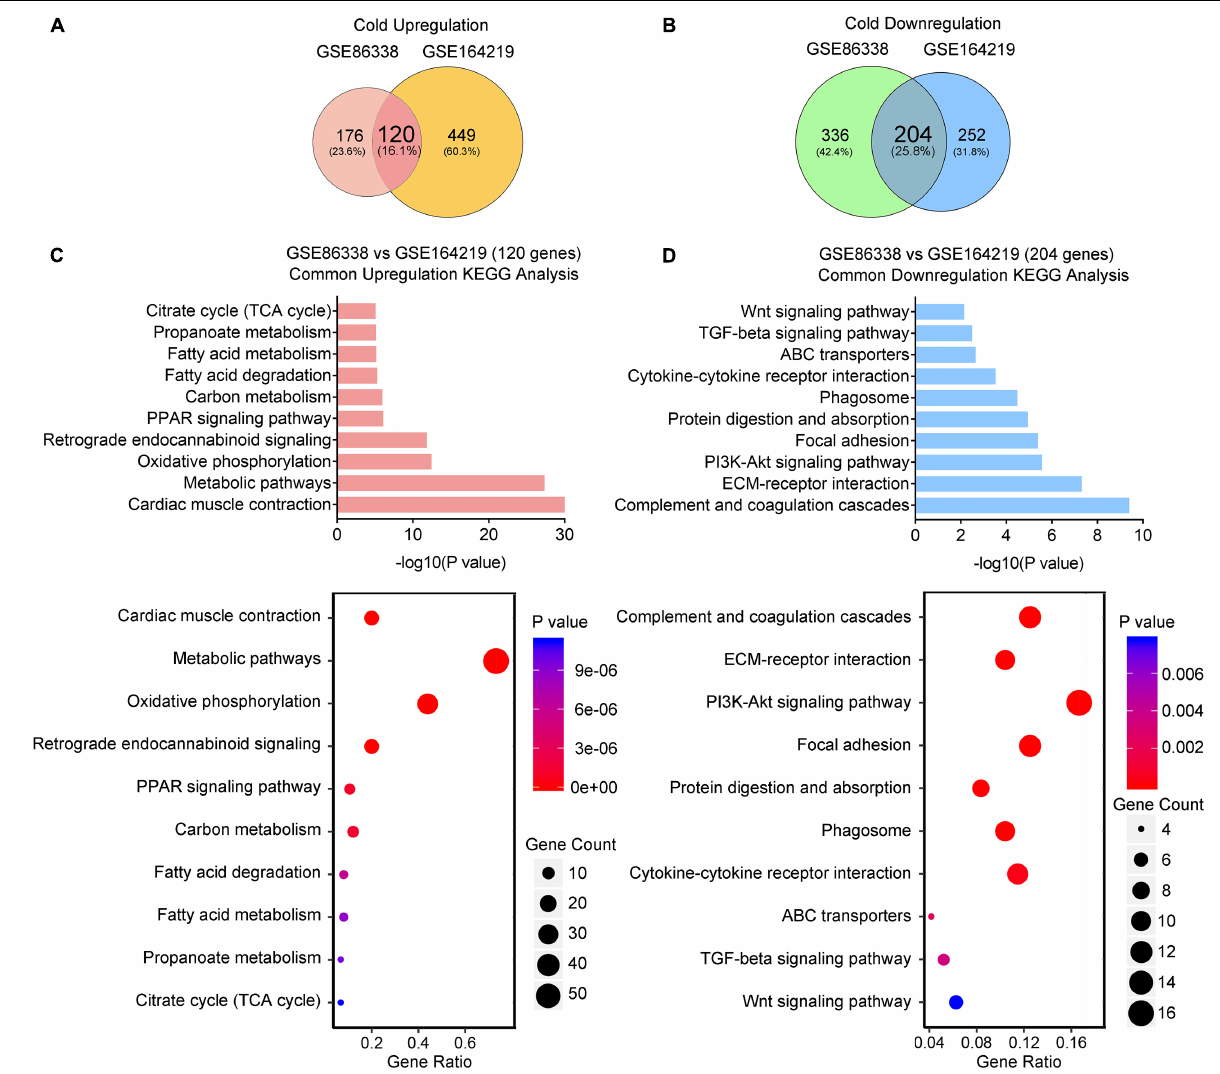
FIGURE 4 | Cold exposure enhances metabolism and inhibits inflammatory and fibrotic pathways in iWAT. (A,B) Venn diagram of overlapped upregulated (A) and downregulated (B) genes from iWAT of mice exposed to cold shown in the GSE86338 and GSE164219 datasets. (C,D) KEGG analysis for the DEGs of common upregulated 120 genes (C) shown in (A) and downregulated 204 genes (D) shown in (B)